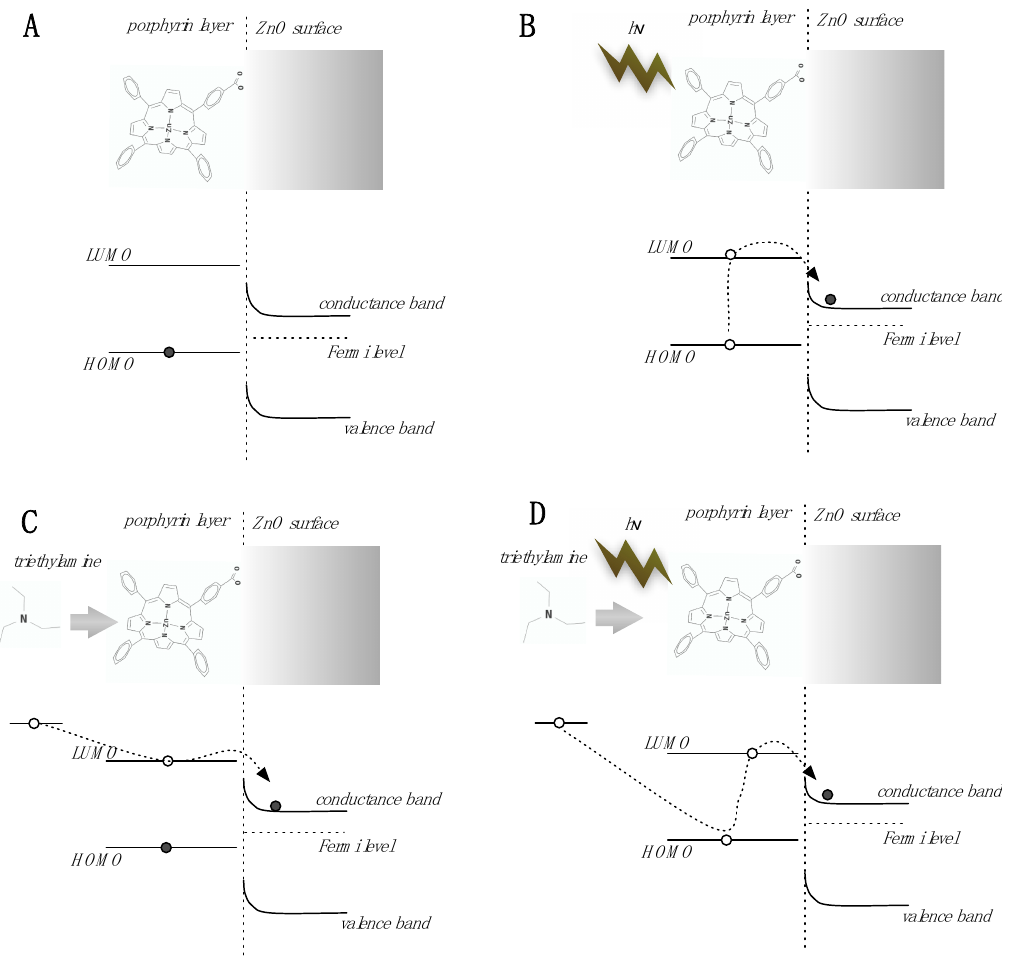
Figure 3. The sensitivity to light, chemicals, and the interaction between them can be understood in terms of an energy bands diagram. In dark conditions ( A ) the highest occupied molecular orbital (HOMO) level of the porphyrin lies below the Fermi level of the semiconductor, then a negligible charge transfer takes place from the porphyrin to the semiconductor. Under visible light ( B ) porphyrin electrons are excited to the lowest unoccupied molecular orbital (LUMO) level above the semiconductor Fermi level, and then the photo-excited charges can be transferred to the conduction band of the ZnO, increasing its conductivity. The adsorption in dark conditions ( C ) of an electron donor species (such as the triethylamine) results in an electron transferred to the LUMO level and then to the conductance band. Finally, under illumination ( D ) the porphyrin HOMO level is depleted by the effect of light, and then the electron transfer from the adsorpbed molecule is facilitated, since the HOMO level is deeper, and any electron at the HOMO level is photo-excited towards the conductance band of the semiconductor. The increase of electrons in the conductance band results in an increase of the conductivity and in a decrease of the surface band bending that changes the surface potential of the material. For the sake of simplicity, the changes of surface band bending are not drawn in the figures.